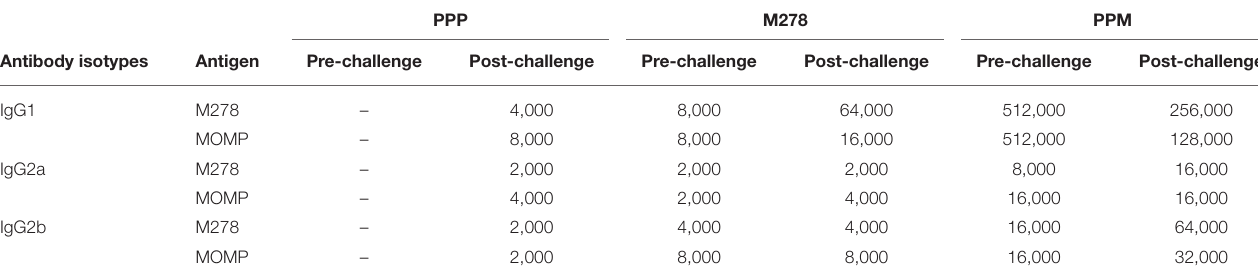
TABLE 1 | Antigen-specific serum-antibody endpoint titers of immunized mice.